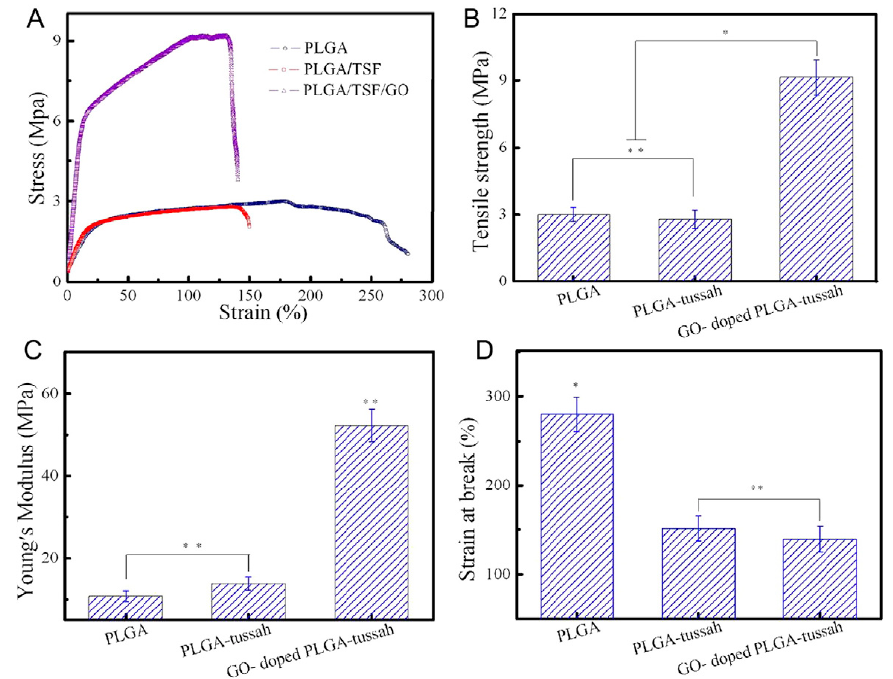
Figure 9. Mechanical properties of the electrospun fibrous pure poly(lactic- co -glycolic acid) (PLGA), PLGA–tussah, and GO-doped PLGA–tussah mats ( n = 10 for each type of nanofibers) tested at room temperature. ( A ) Typical stress–strain curves; ( B ) tensile strength; ( C ) Young’s modulus; and ( D ) strain at break (* p < 0.05, ** p < 0.01). Reprinted from [165] with permission from Elsevier.